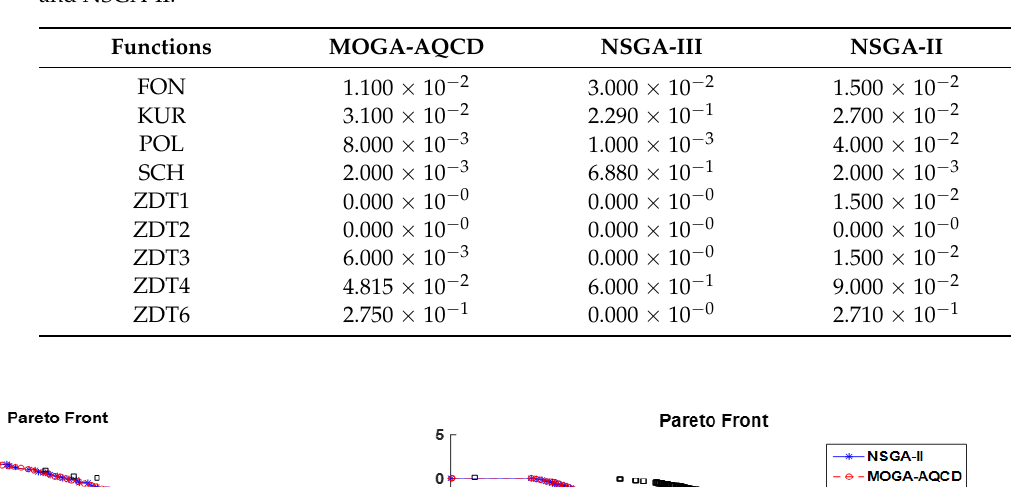
Table 7. Average set coverage values of HAES compared to those of MOGA-AQCD, NSGA-III, and NSGA-II.